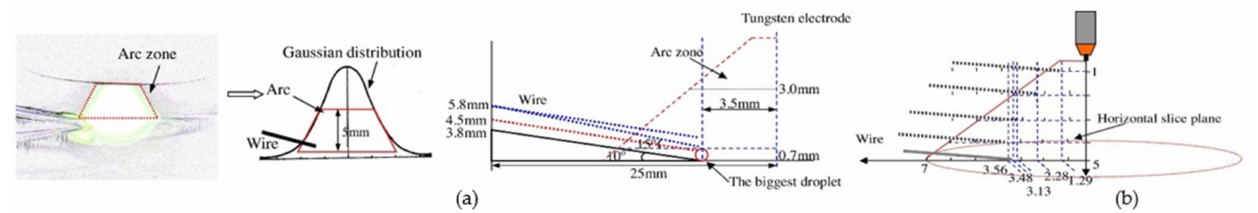
Figure 42. Schematic of Wire feed unit. Reprinted with permission from Ref. [83]. Copyright 2017 Elsevier.